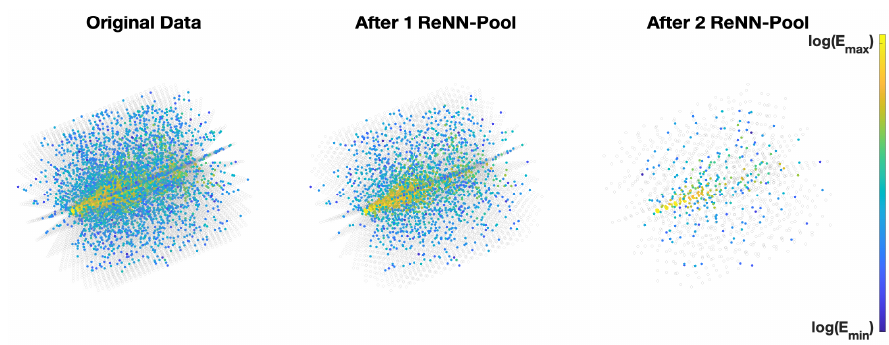
Figure 4. Dataset and ReNN-Pool . From the left, the panels show the representation of a typical example from the energy deposition datasets and two pooled representations of the same example. The nodes in light grey have null features, while all others show an energy distribution within the considered